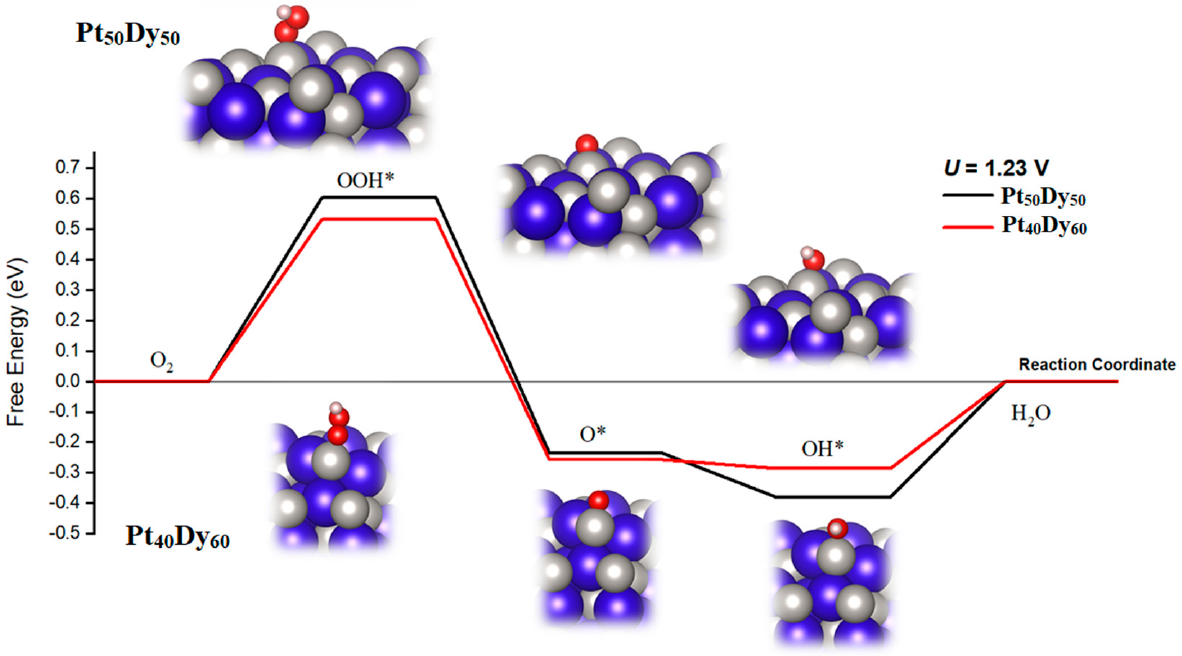
Figure 6. ORR (direct reaction) or OER (reverse reaction) free energy profiles for Pt 50 Dy 50 and Pt 40 Dy 60 phases at equilibrium potential, along with the optimized structures of ORR intermediates (OOH, O, and OH) on studied surfaces. Grey—Pt, blue—Dy atoms, * refers to adsorbed species.